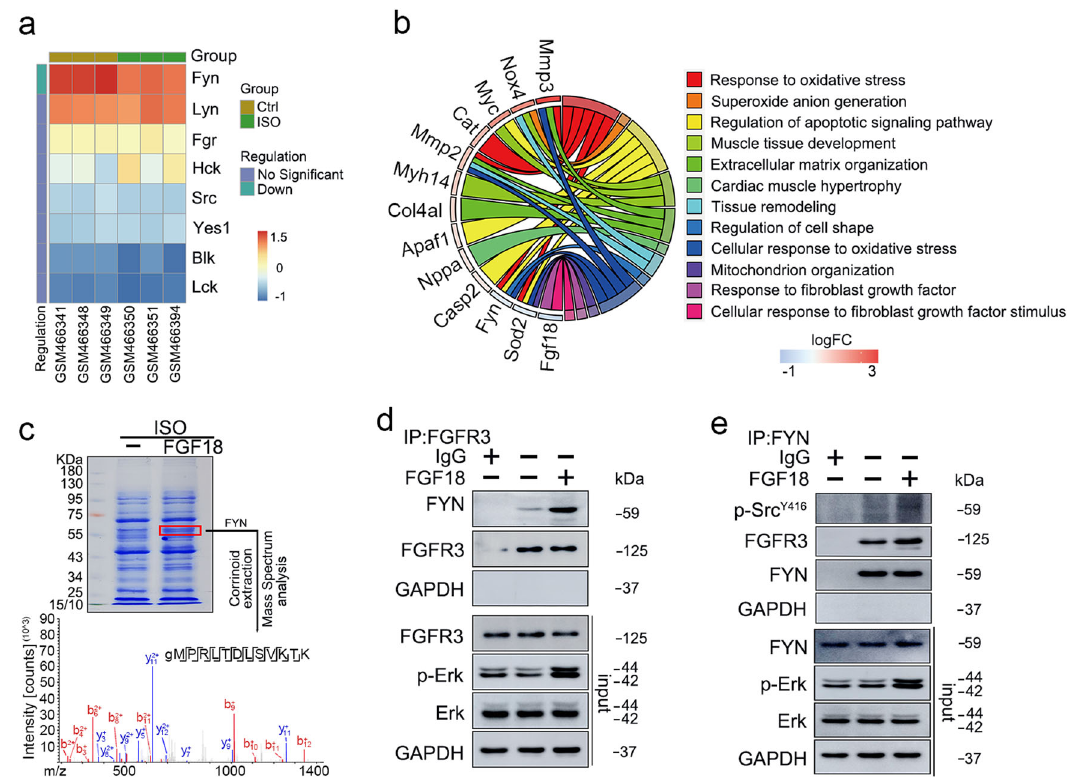
Fig. 5 | FYN expression is downregulated by hypertrophic stimuli and rescued by FGF18/FGFR3.a The corresponding Srcfamilykinases correlated with the non- hypertrophic myocardium and hypertrophic myocardium were visualized by the heatmapinthenormalandISOtreatmentsamplesinGSE18801dataset.Thedarker shade of red or blue represents the higher correlationlevel. b Circleplotdepicting theimportantsignalpathwaysassociatedwithrelatedgenes. c NRCMsweretreated with ISO (10 μ M) in the presence or absence of FGF18 (50ng/ml) for 48h. Protein bands at ~60kDa were excised from the SDS-PAGE gels for LC-MS/MS analysis. d NRCMs were treated with FGF18 (50ng/ml) for 10min. The cell lysates were